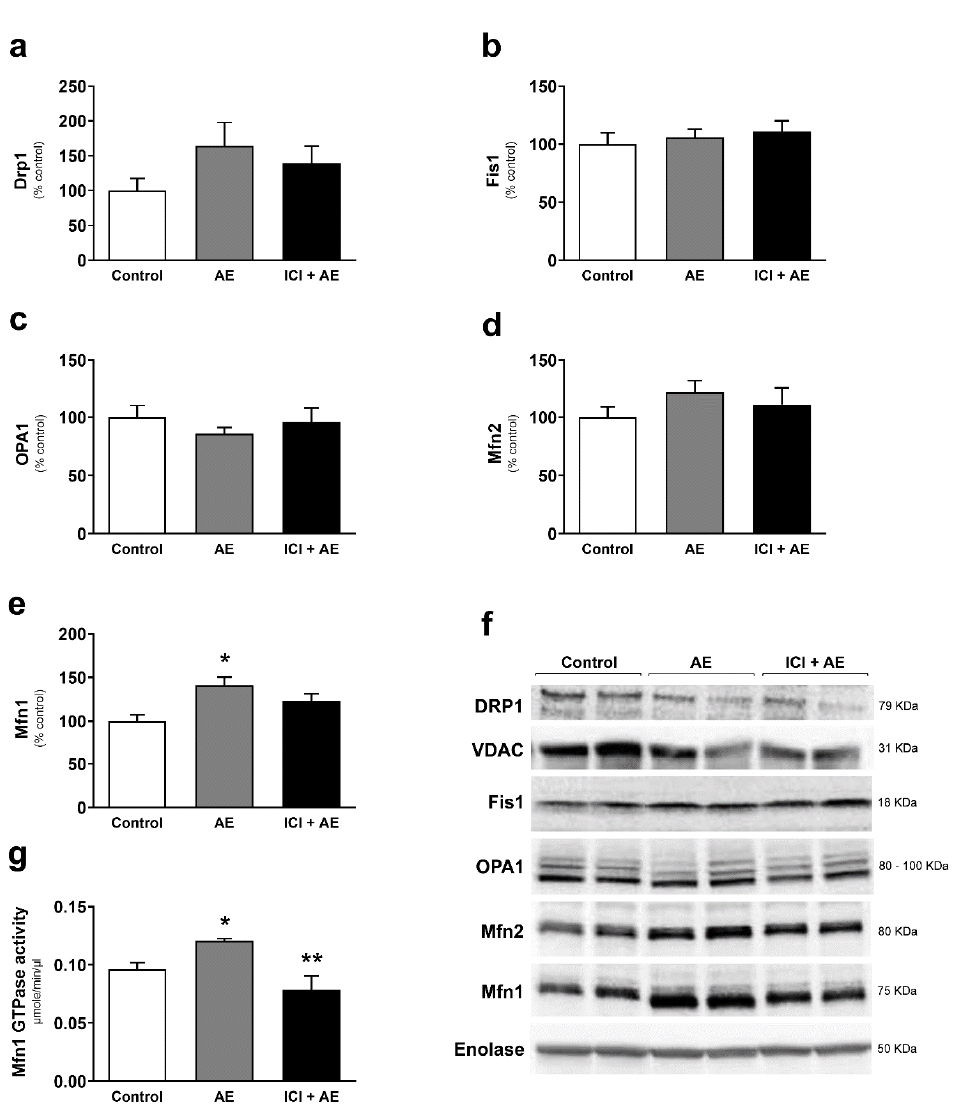
Figure 3. Exercise-induced skeletal muscle mitochondrial fusion is associated with increased Mfn1 expression and activity, mediated by β 2 -ARs. DRP1 (mitochondrial fraction) ( a ), Fis1 ( b ), OPA1 ( c ), Mfn2 ( d ), and Mfn1 ( e ) protein expression, immunoblotting representative images ( f ), and Mfn1GTPase activity ( g ) in tibialis anterior muscles from exercised mice (single bout in a treadmill—80% of Vmax for 1 h, 5° inclination), with or without β 2 -AR receptor blockade with ICI 118,551 (single dose—10 mg/kg, i.p., 30 min prior exercise). Enolase and VDAC were used as loading control for total lysate and mitochondrial fraction protein expression, respectively. Data are presented as mean ± SE. * p < 0.05 vs. control and ** p < 0.05 vs. AE. n = 5/group.